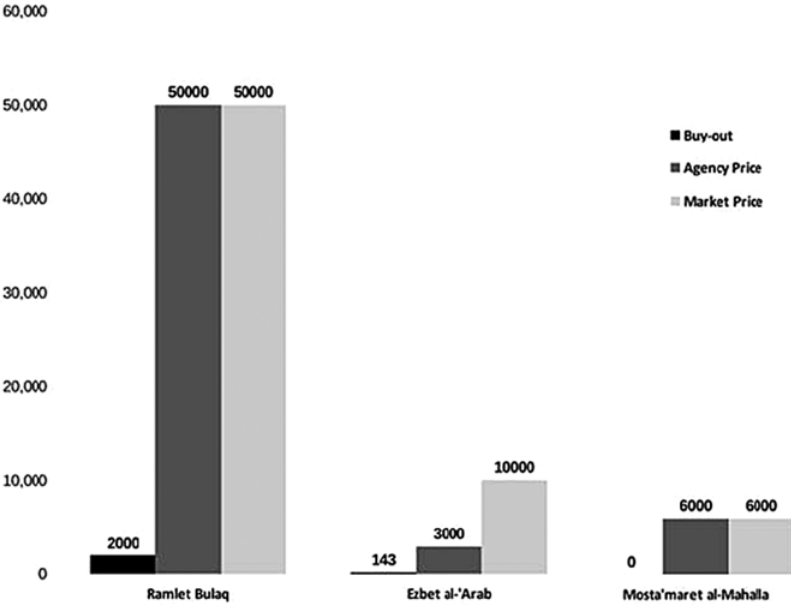
Figure 4. Rent-gap between what the government agencies may pay to buy out residents, the values they may sell the land on to private investors, and the estimated market value of the land. (EGP/m 2